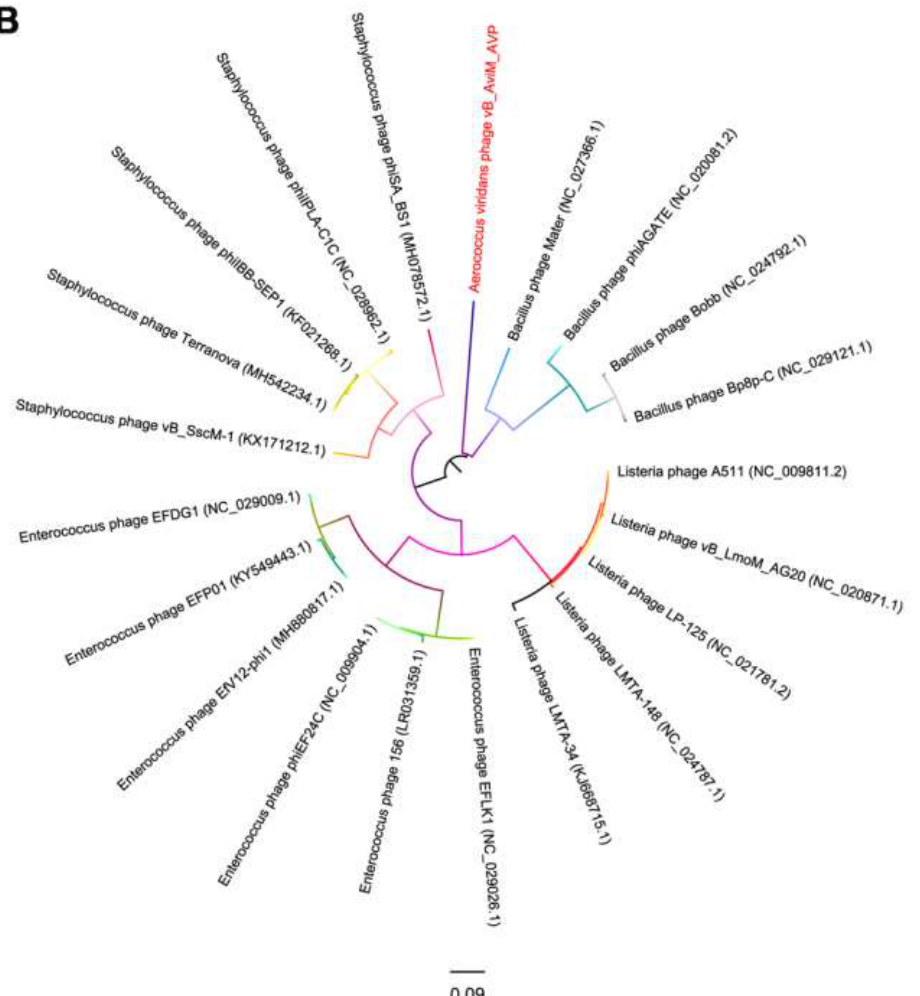
Figure 5. Phylogenetic tree based on the terminase large subunits ( A ) and capsid proteins ( B ) of selected phages. Both the terminase large subunits and capsid proteins were compared using PhyML version 3.0, and the phylogenetic trees were generated using the maximum likelihood method with 100 bootstrap replicates.